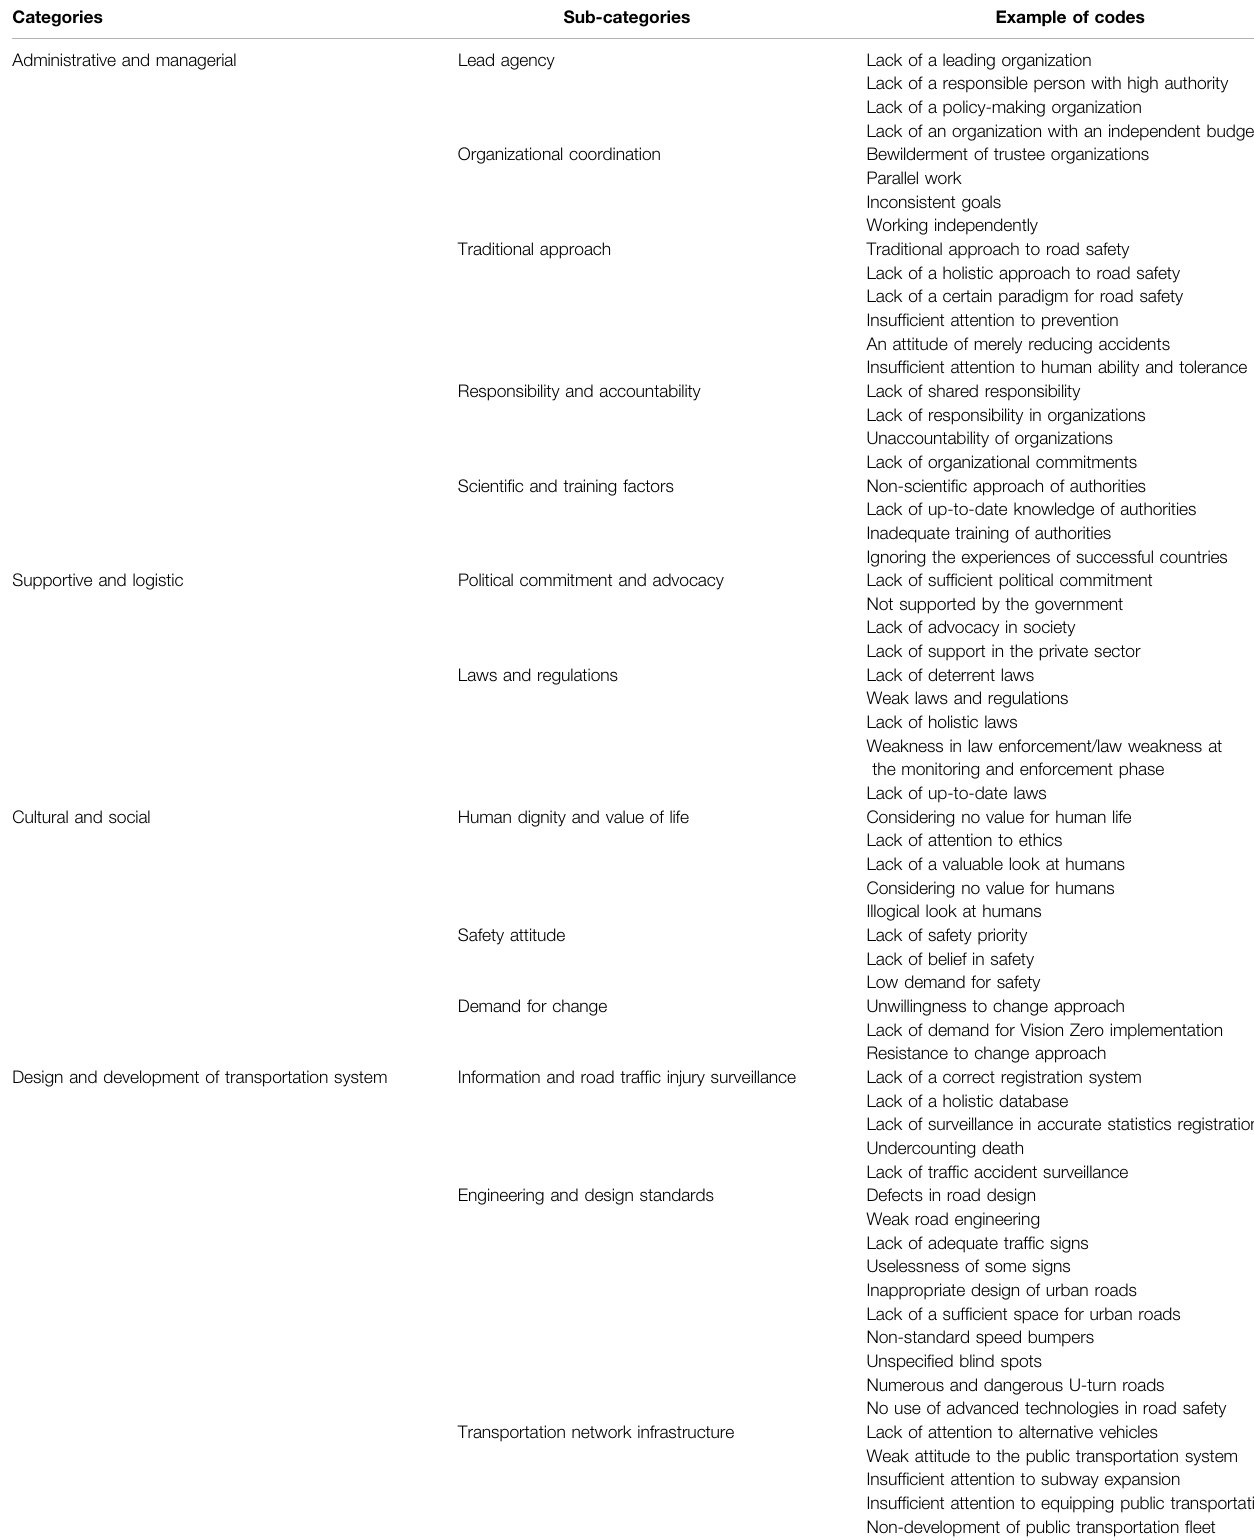
TABLE 2 | Codes, sub-categories, and categories of the challenges of Vision Zero implementation in